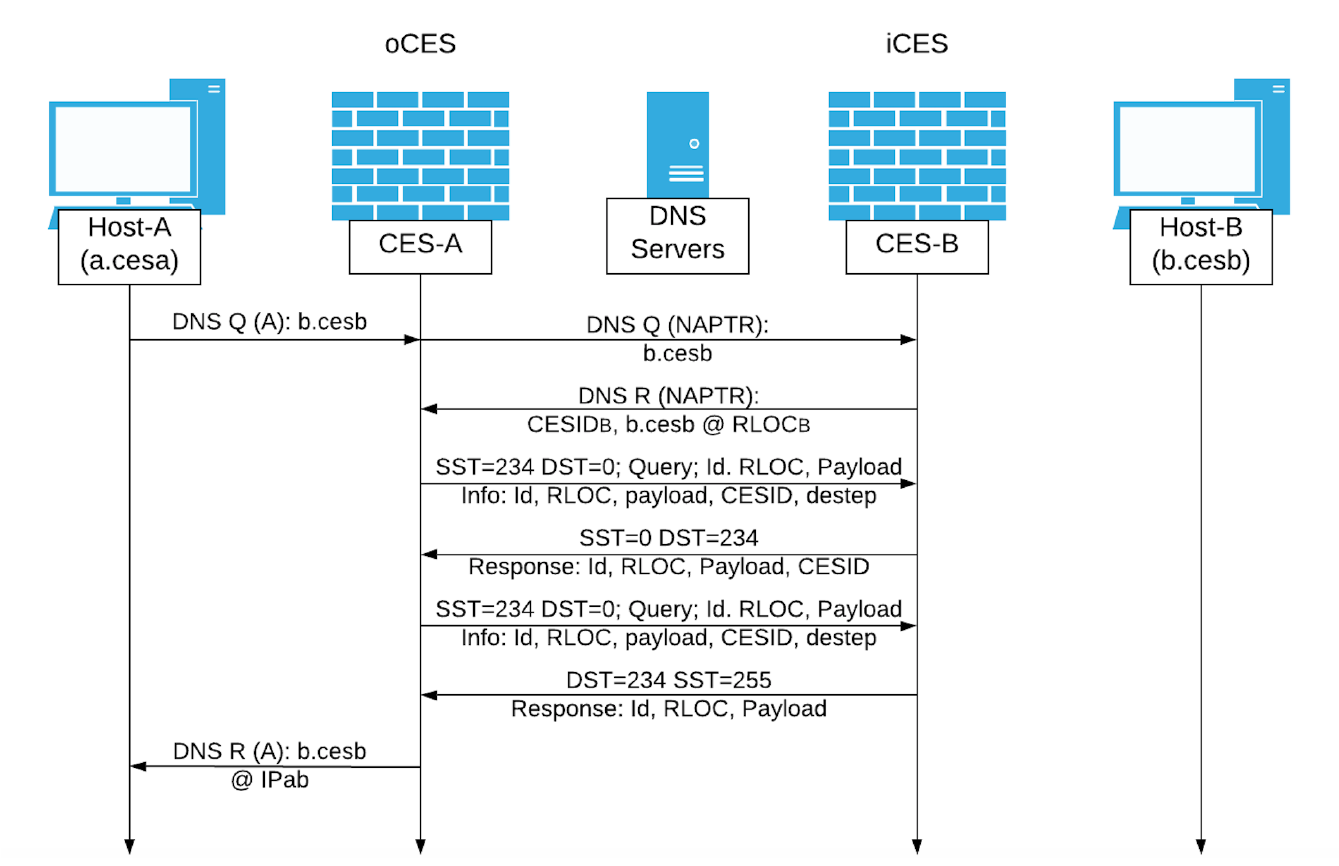
Figure 8. CETP connection establishment—2 RTT [8]. Table 3. Exemplary output of the Passive DNS. First